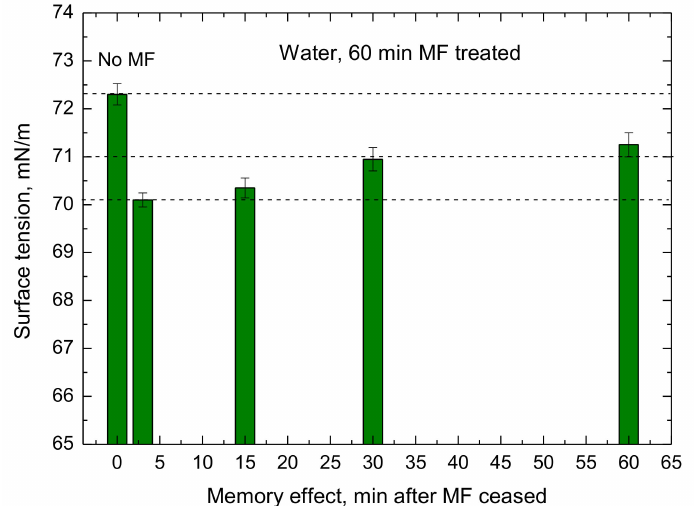
Figure 11. Changes in the water surface tension of 1 h MF-treated samples as a function of time when the field had ceased—memory